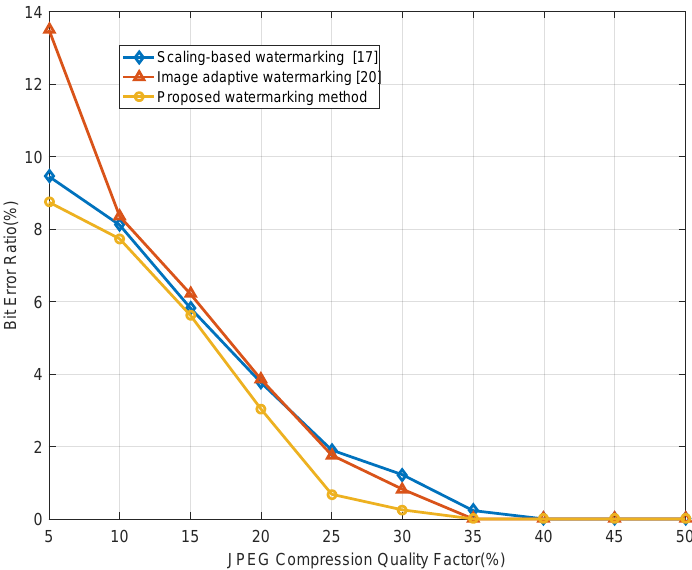
Figure 4. Performance comparison of various algorithms under JPEG compression